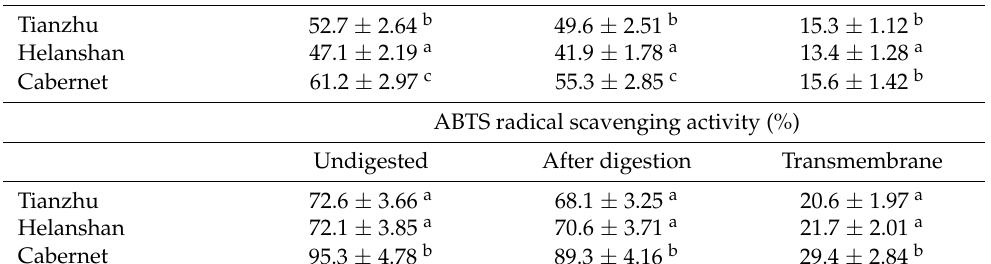
Table 3. Antioxidant activity of red wine at different digestion phases.